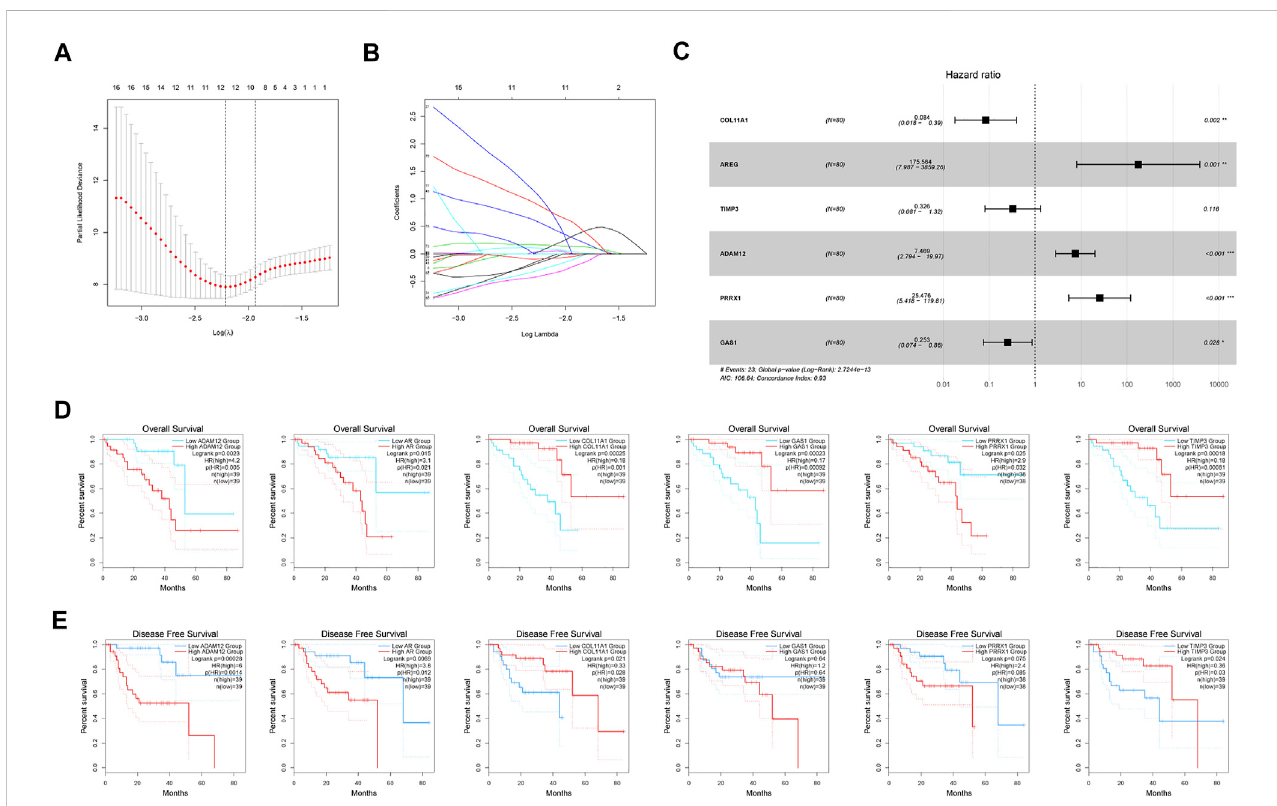
FIGURE 3 Development of the MAGs-based score system. (A – B) LASSO coef fi cient pro fi le analysis. (C) Six MAGs identi fi ed for score system (* p < 0.05, ** p < 0.01, *** p < 0.001). Kaplan-Meier curves of (D) OS and (E)